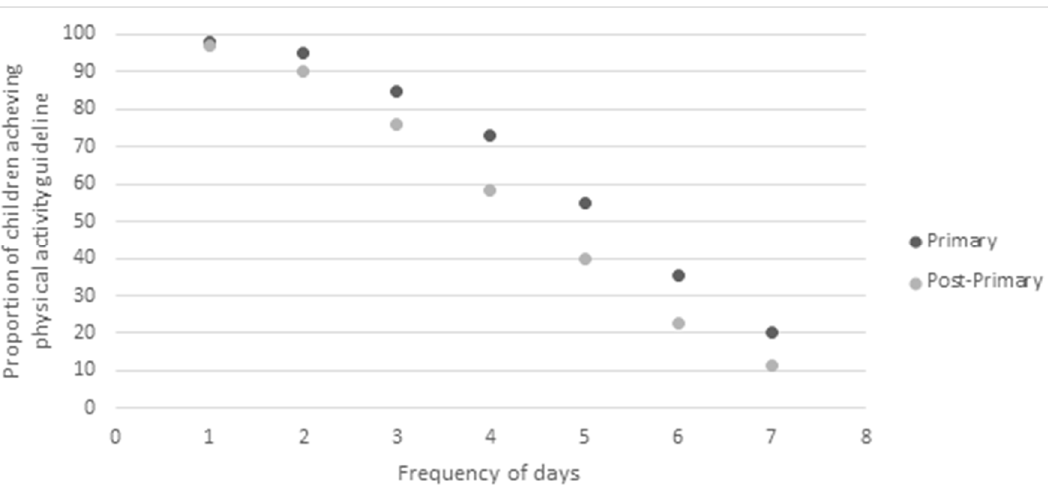
Figure 1. Proportion of primary and post-primary school children achieving 60 min of moderate-to- Figure vigorous physical activity (MVPA) per day.